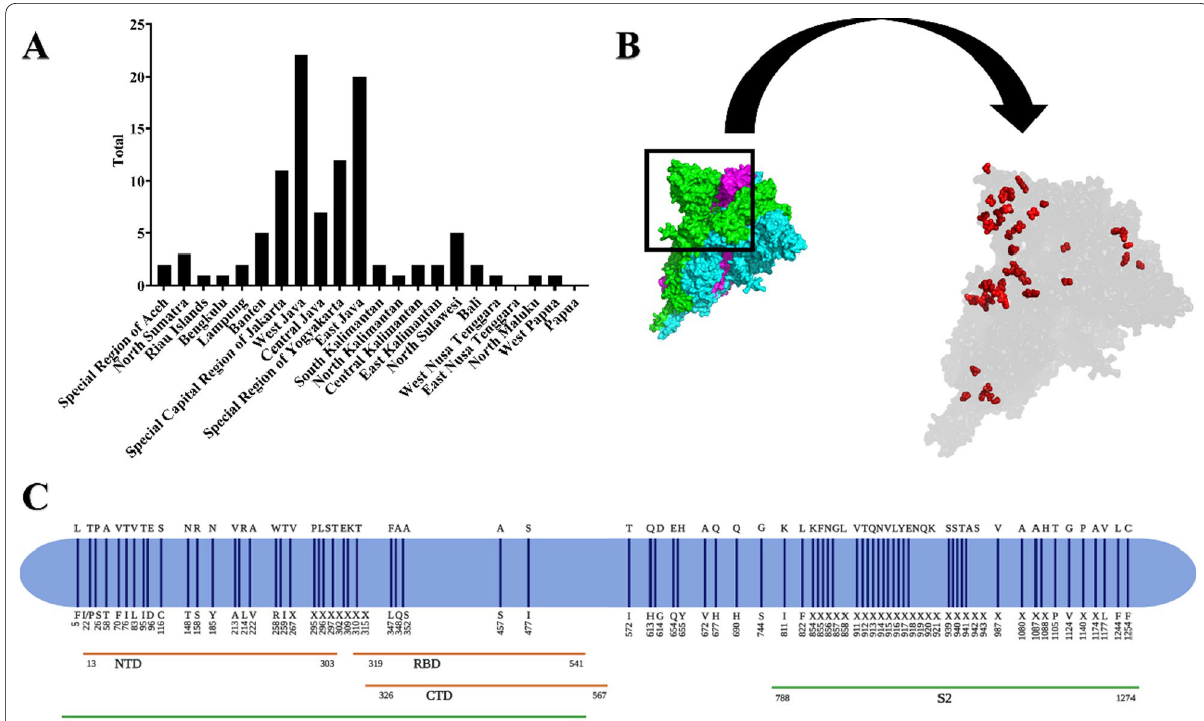
Fig. 2 Mutation analysis originated from S protein of Indonesian SARS-CoV-2 isolates. A Distribution of D614G mutation from various provinces in Indonesia; B 3D structure visualization of SARS-CoV-2 S protein. Red dots are the location of various mutations in S protein; C The mapping of amino acid mutation sites in S protein of 166 Indonesian SARS-CoV-2